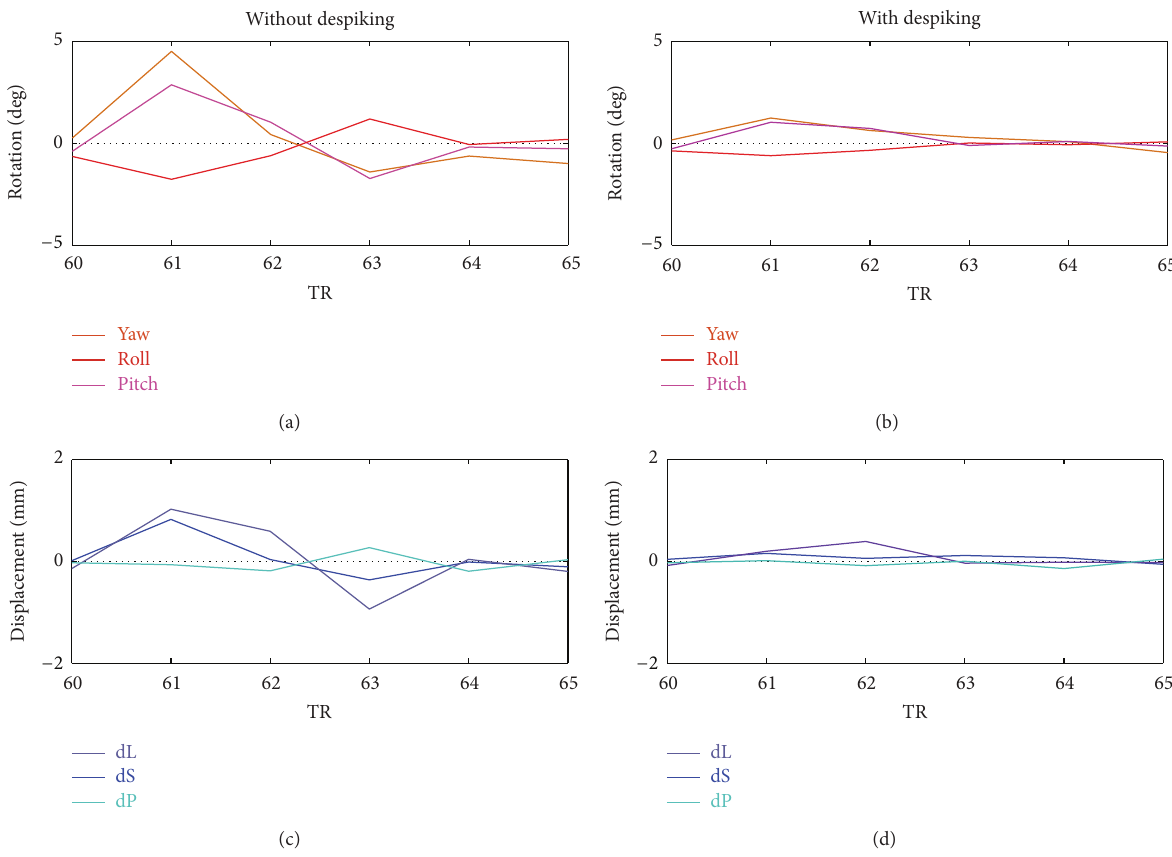
Figure 2: Improved motion correction by adding despiking step. The 6 motion estimates are from time frames in the corresponding video file (Supplementary Material S1). The upper and lower rows show the rotation and translation estimates, respectively, and the left and right columns show the motion estimates from the volume registration of FMRI data processed by pipelines starting without and with despiking, respectively. Registration without despiking resulted in visible residual motion between the 60th and 65th time frames. This suggests that the more elevated motion estimates obtained without despiking are less accurate than those with despiking. The subject used is sub0015004 , who had the largest head movements in the children